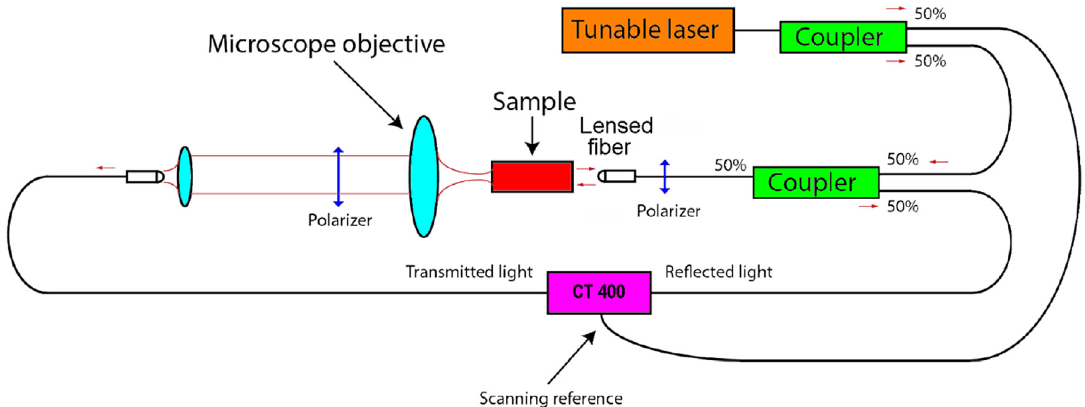
Figure 5: Presentation of the setup used to measure the transmission and reflection characteristics of our